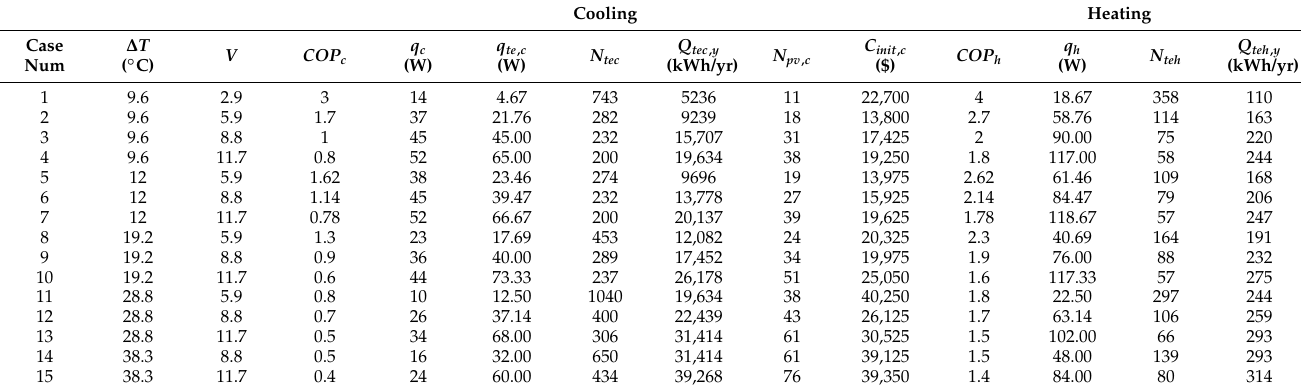
Table 4. Summary of the results for various operating